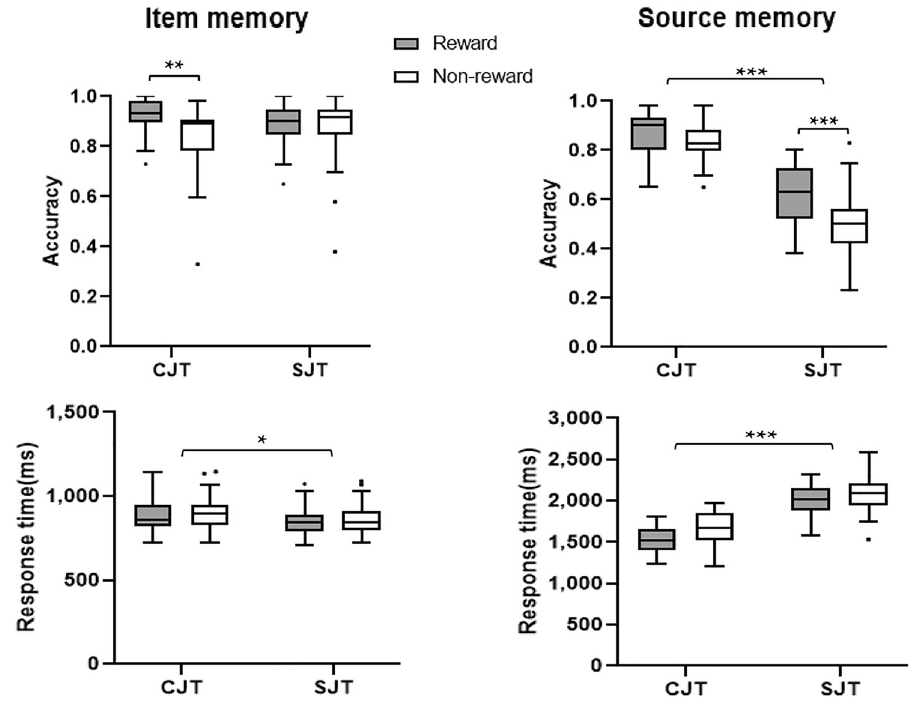
Figure 2. Behavioral performance across conditions for item memory and source memory. CJT, congruity- judgment task; SJT, size-judgment task. * p < 0.05, ** p < 0.01, *** p <